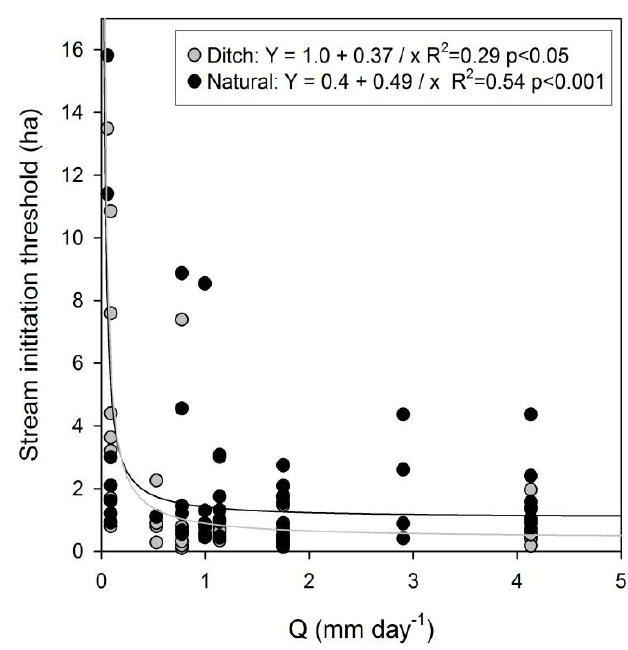
Figure 2. Stream initiation threshold area (ha), also known as channelization threshold or source area, for the stream heads of natural streams and ditches, respectively. The dots denote field measurements on till soils during different flow situations (Q), i.e. , how much land area (ha) is needed before a stream develops.